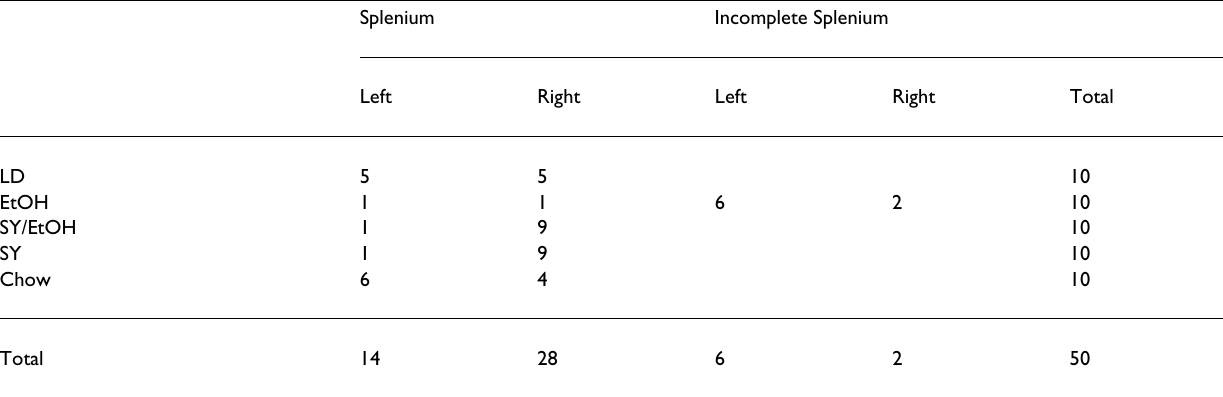
Table 3: Splenium Development and Paw